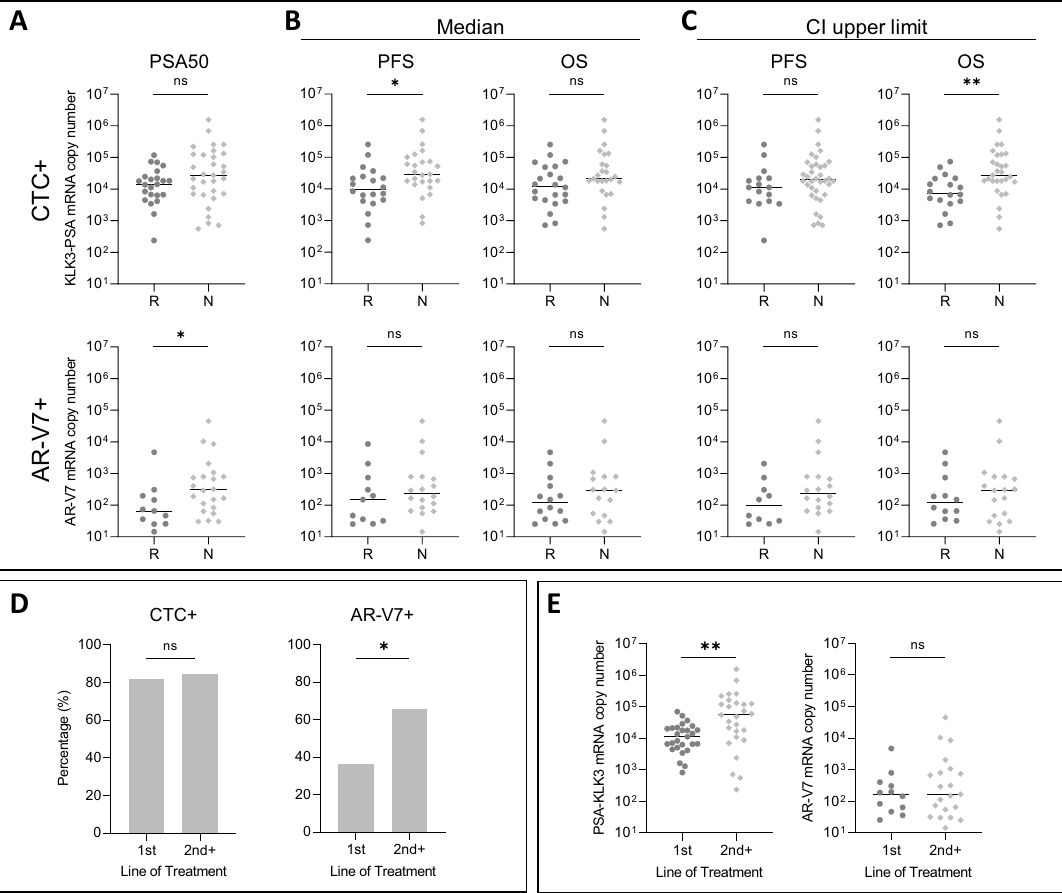
Figure 4. Correlation analysis of responding (R) and non-responding (N) patients and copy number distribution/biomarker appearance and levels. Comparison of mRNA copy numbers KLK3-PSA (upper panel) and AR-V7 (lower panel) per blood sample (5 ml) in biomarker positive patients (upper panel: CTC +; lower panel: AR-V7 +) regarding ( A ) PSA response, ( B ) PFS and OS categorized into responders ((R); PFS and OS duration > median PFS and OS) and non-responders ((N); PFS and OS duration < median PFS and OS) and ( C ) PFS and OS categorized into responders ((R); PFS and OS duration > CI upper limit for PFS and OS) and non-responders ((N); PFS and OS duration < CI upper limit for PFS and OS). P values (Mann–Whitney test) are as follows. CTC +: PSA50: p = 0.11; Median, PFS: p < 0.02, OS: p = 0.11; upper limit: PFS: p = 16, OS: p <